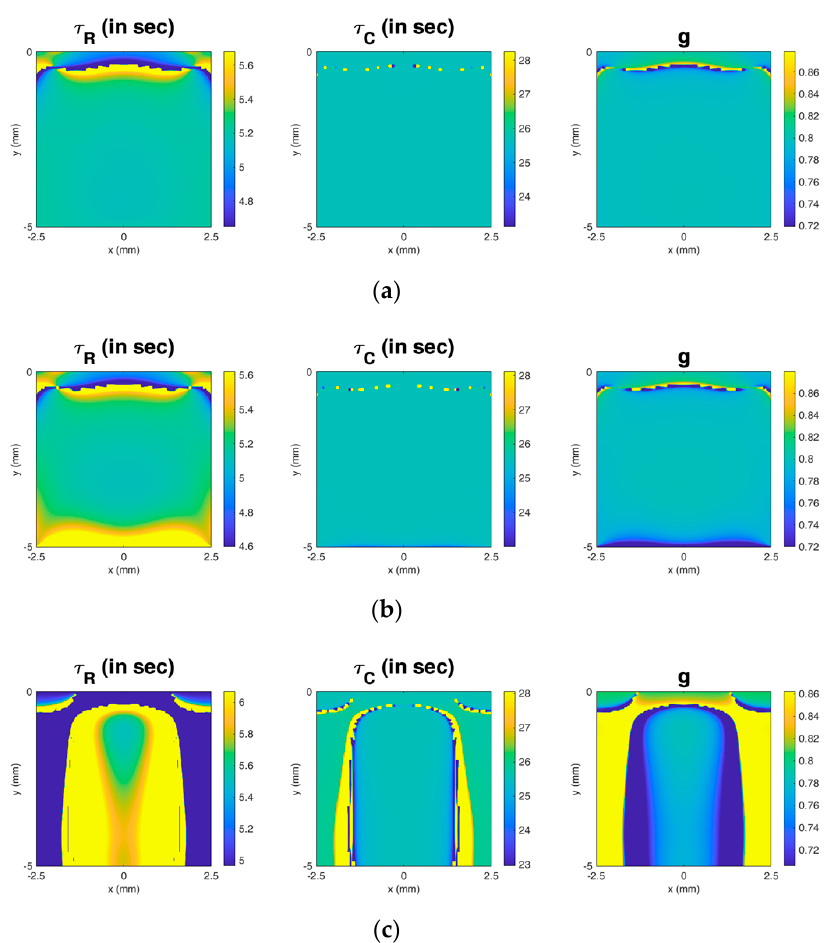
Figure 8. The effect of the type of boundary conditions on the measurement results. In the images, the region providing accurate measurement results shows turquoise color. ( a ) The bottom is constrained along the depth direction while the side and top are not constrained. ( b ) The bottom is constrained along all directions while the side and top are not constrained. ( c ) The bottom is constrained along the depth direction and the side is constrained along the lateral direction, while the top is not